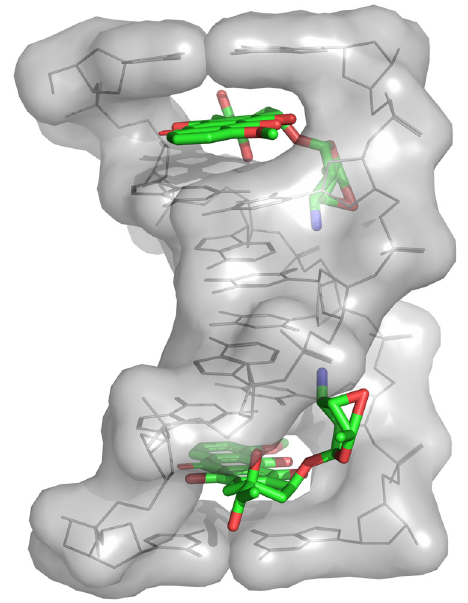
Figure 1. The crystal structure of DNA–daunomycin complex (PDB 1DA0).